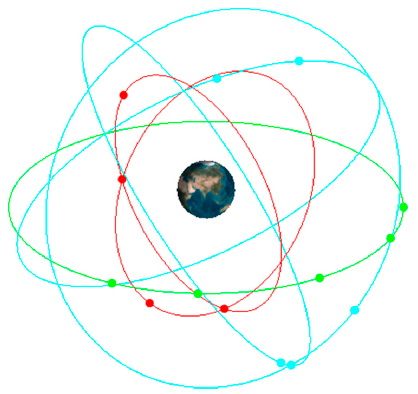
Figure 14. BeiDou satellites. Table 2. Computational set up for positioning example.